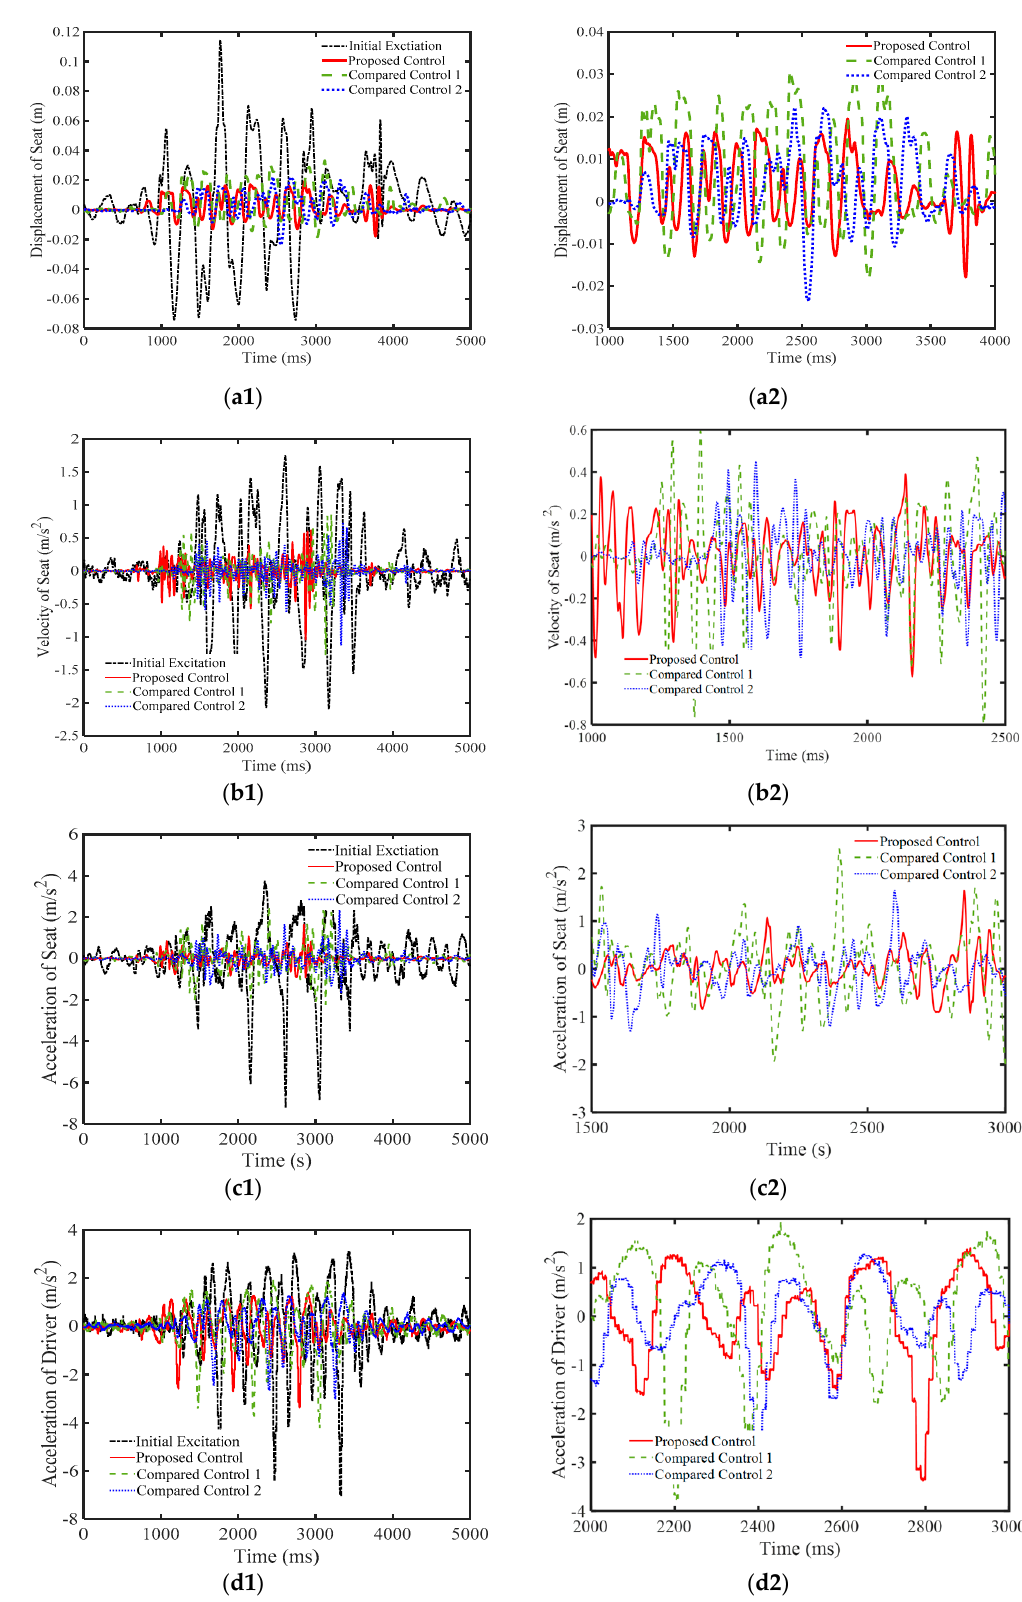
Figure 7. Experiment results under random-step-wave excitation: ( a1 ) displacement; ( a2 ) large view of the displacement; ( b1 ) velocity; ( b2 ) large view of the velocity; ( c1 ) acceleration at the seat; ( c2 ) large view of the acceleration at the seat; ( d1 ) acceleration of the driver; and ( d2 ) large view of the acceleration of the